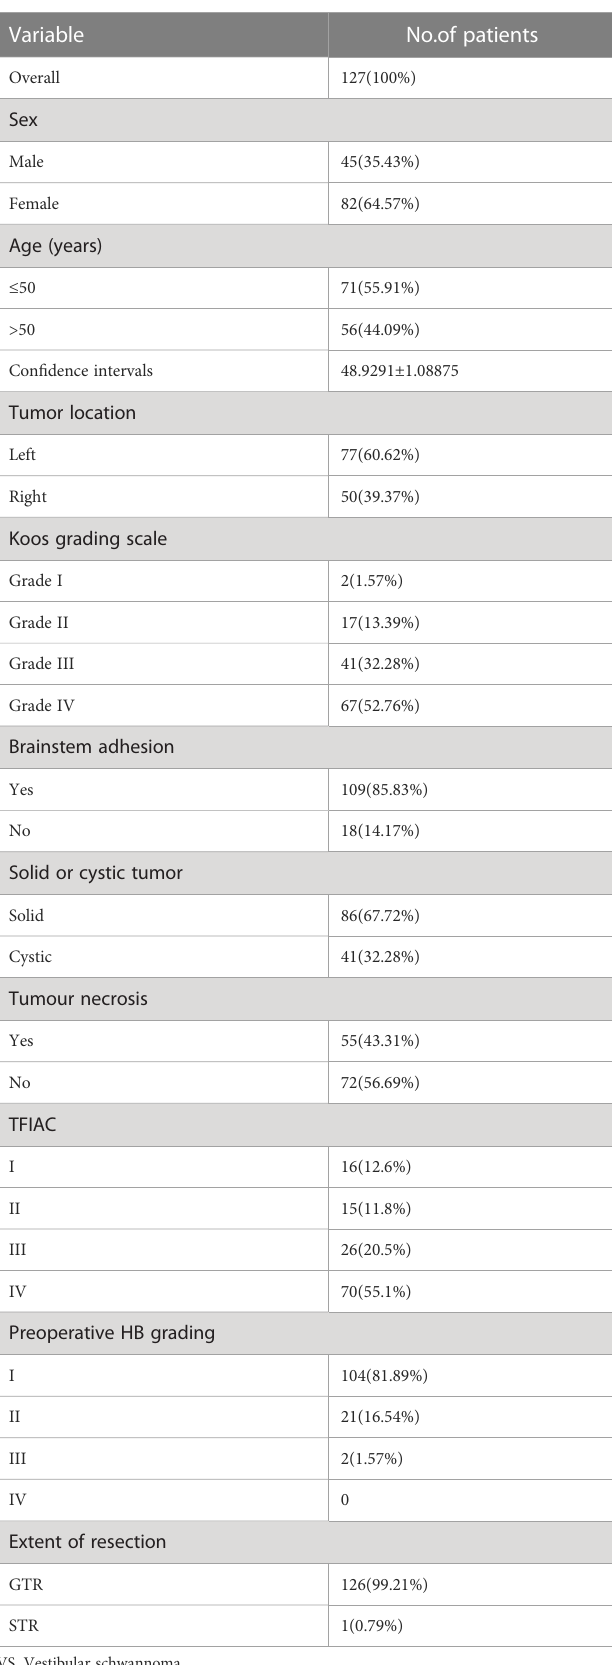
TABLE 1 Baseline characteristics of 127 patients with